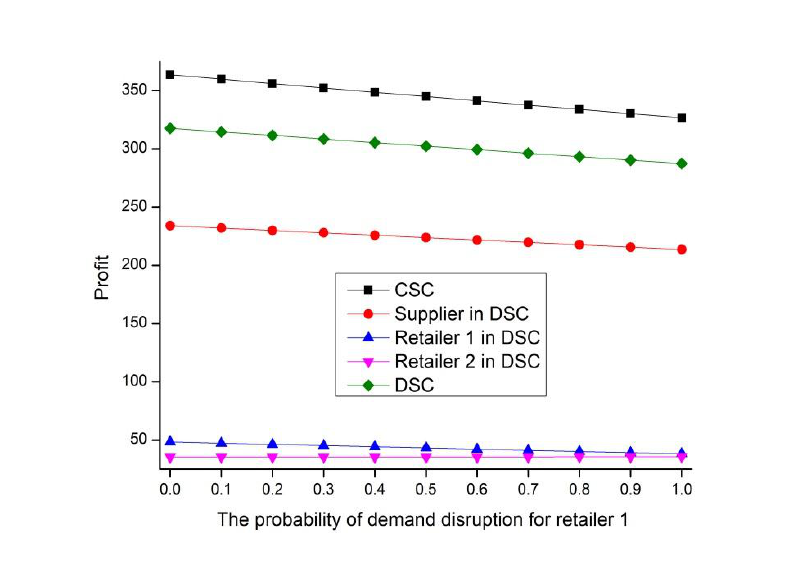
Figure 3. The profit versus the probability of demand disruption for retailer 1